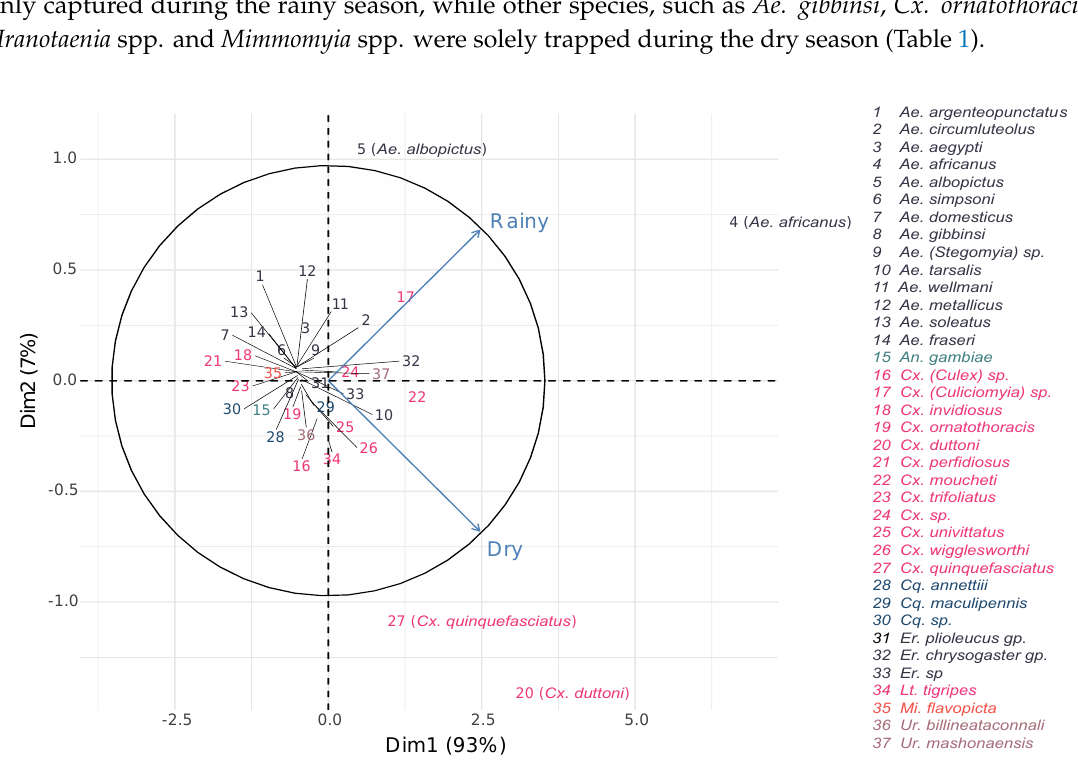
Figure 5. Principal component analysis representing the relationship between mosquito species abundance and seasons.